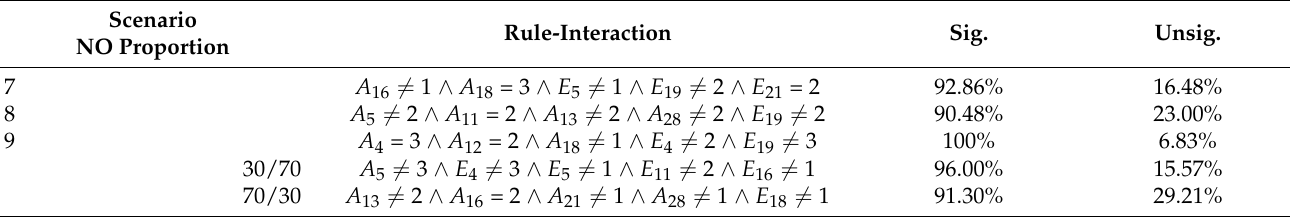
Table 7. Decision rules of the standard SMO approach regarding work task